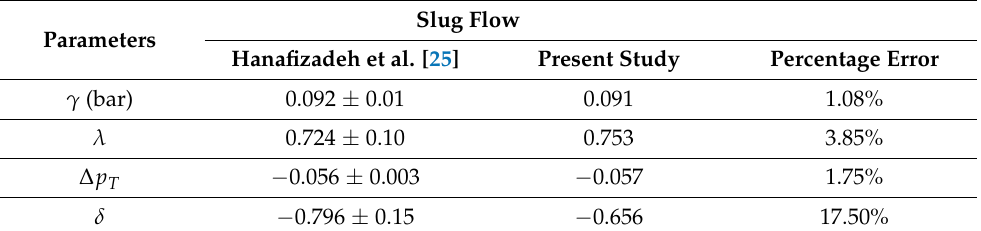
Table 2. Comparison of present model and Hanafizadeh et al. [25] for various pressure parameters.